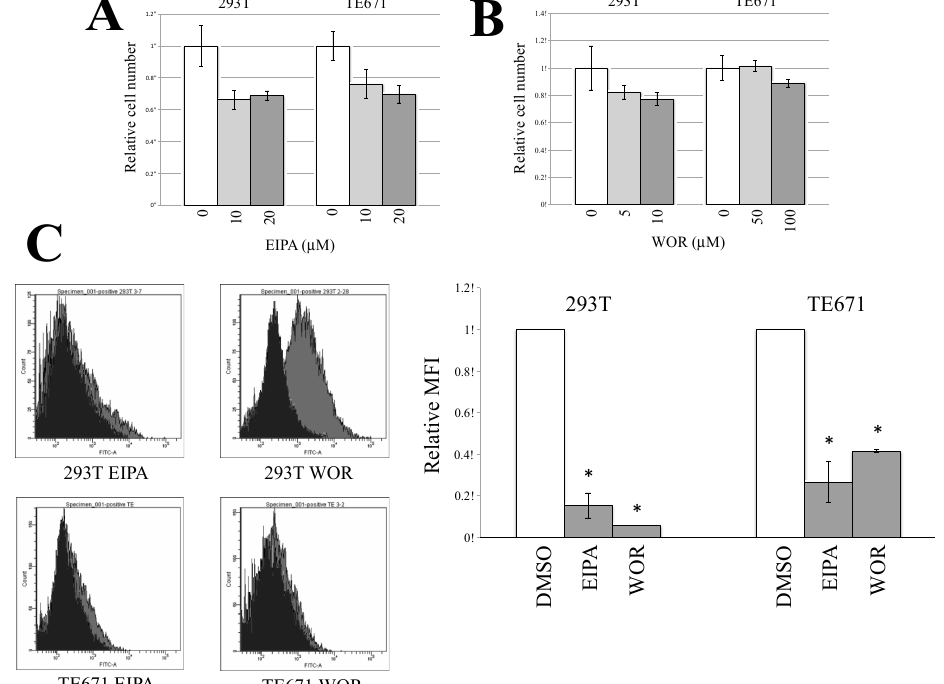
Figure 3. E ff ects of macropinocytosis inhibitors on cell viability and macropinocytosis. ( A and B ) 293T and TE671 cells were treated with 5-(N-ethyl-N-isopropyl)-amiloride (EIPA) or wortmannin (WOR) for 5 h. The culture supernatants were changed to fresh medium without the inhibitors, and continued to be cultured for 24 h. Cell numbers were counted. This experiment was performed in triplicate. Relative values to numbers of cells treated with same volume of DMSO. Averages are shown. Error bars indicate standard deviations. Asterisks indicate statistically significant di ff erences compared to the values in DMSO-treated cells. ( C ) Fluorescein isothiocyanate (FITC)-conjugated dextran (molecular weight > 70,000) internalized into cells by macropinocytosis was measured using a flow cytometer (left panel). Relative values to the means of fluorescence intensities (MFIs) in DMSO-treated cells are indicated (right panel). MFIs in the DMSO-treated cells are always set to 1. This experiment was repeated in triplicate, and averages are shown. Error bars indicate standard deviations. Asterisks indicate statistically significant di ff erences compared to the values in DMSO-treated cells.